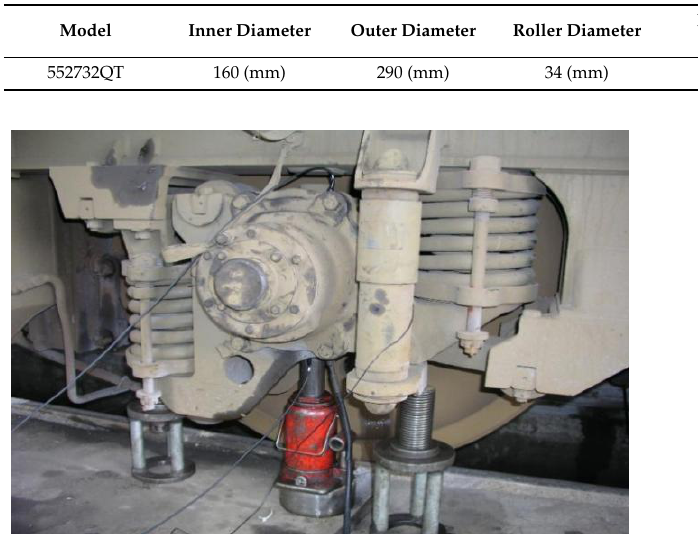
Table 4. Experimental rolling bearing parameters.